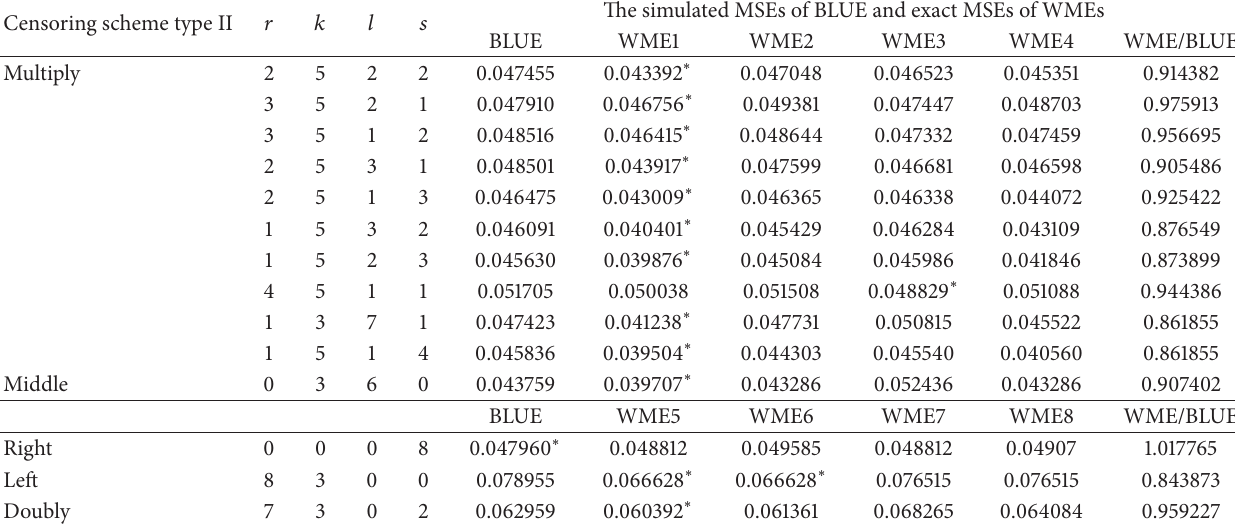
Table 4: MSEs of BLUE and WMEs of the location parameter 𝜃 at 𝑁 = 25 , 𝜎 = 1.0 , and 𝜃 = 1